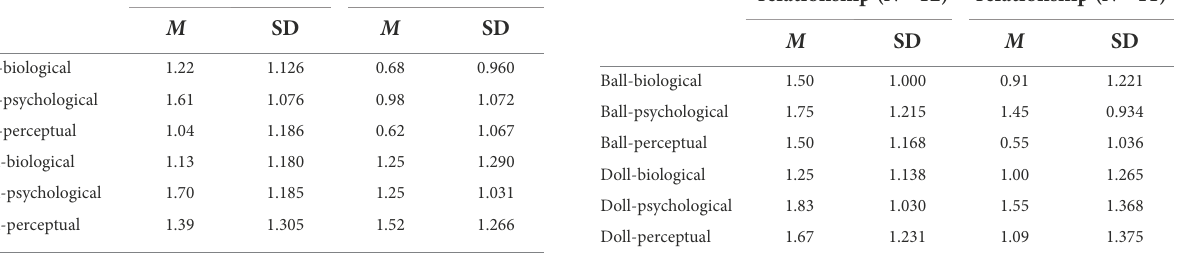
TABLE 5 Mean and standard deviation of agency attributions to ball and doll for imaginary companion status. With ICs ( N = 23)